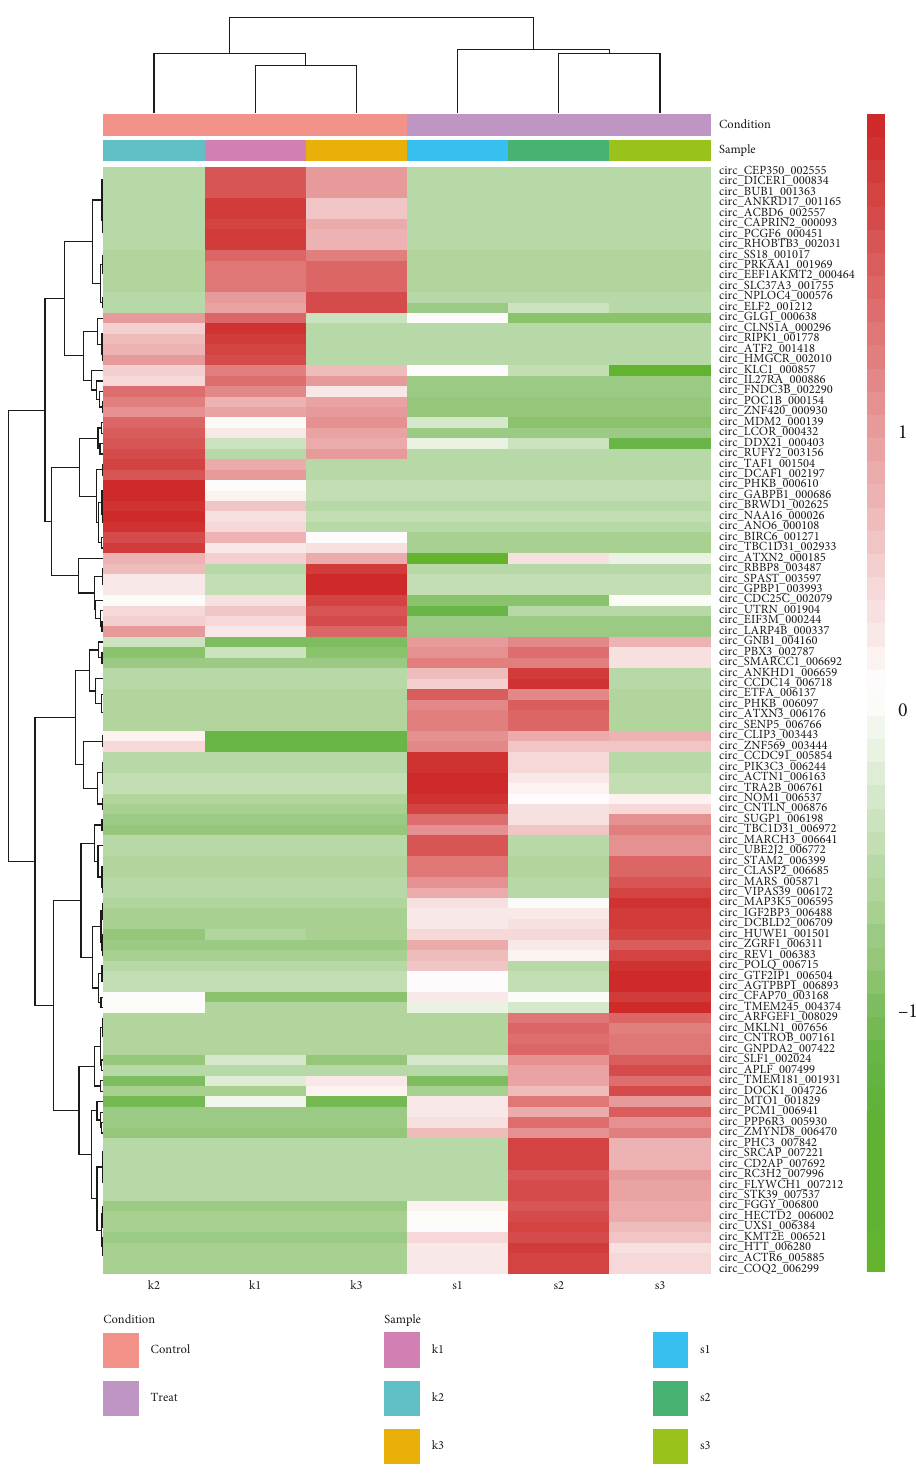
Figure 2: The clustering heatmap of the differentially expressed circular RNAs (circRNAs). s1, s2, and s3 represent the samples in the treatment group. k1, k2, and k3 represent the samples in the control